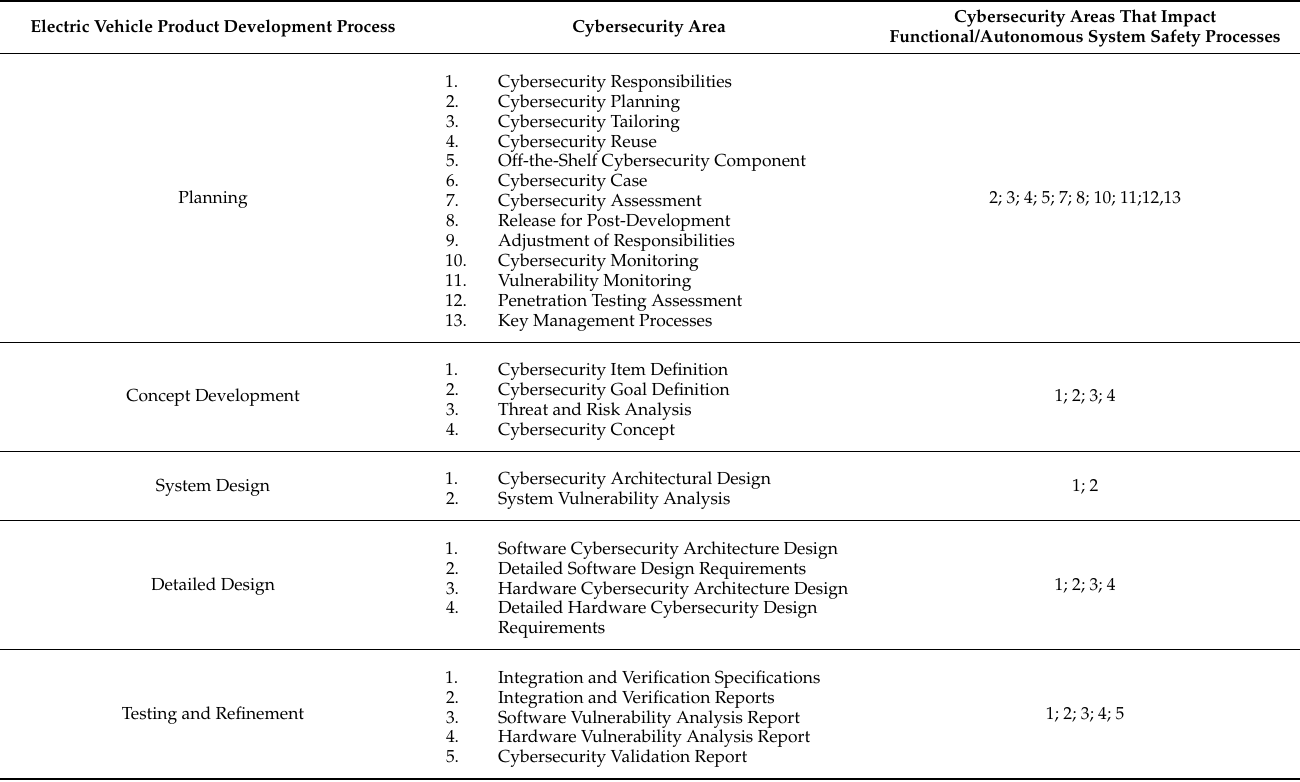
Table 3. Cybersecurity processes impacting the product development processes of electric vehicles. Electric Vehicle Product Development